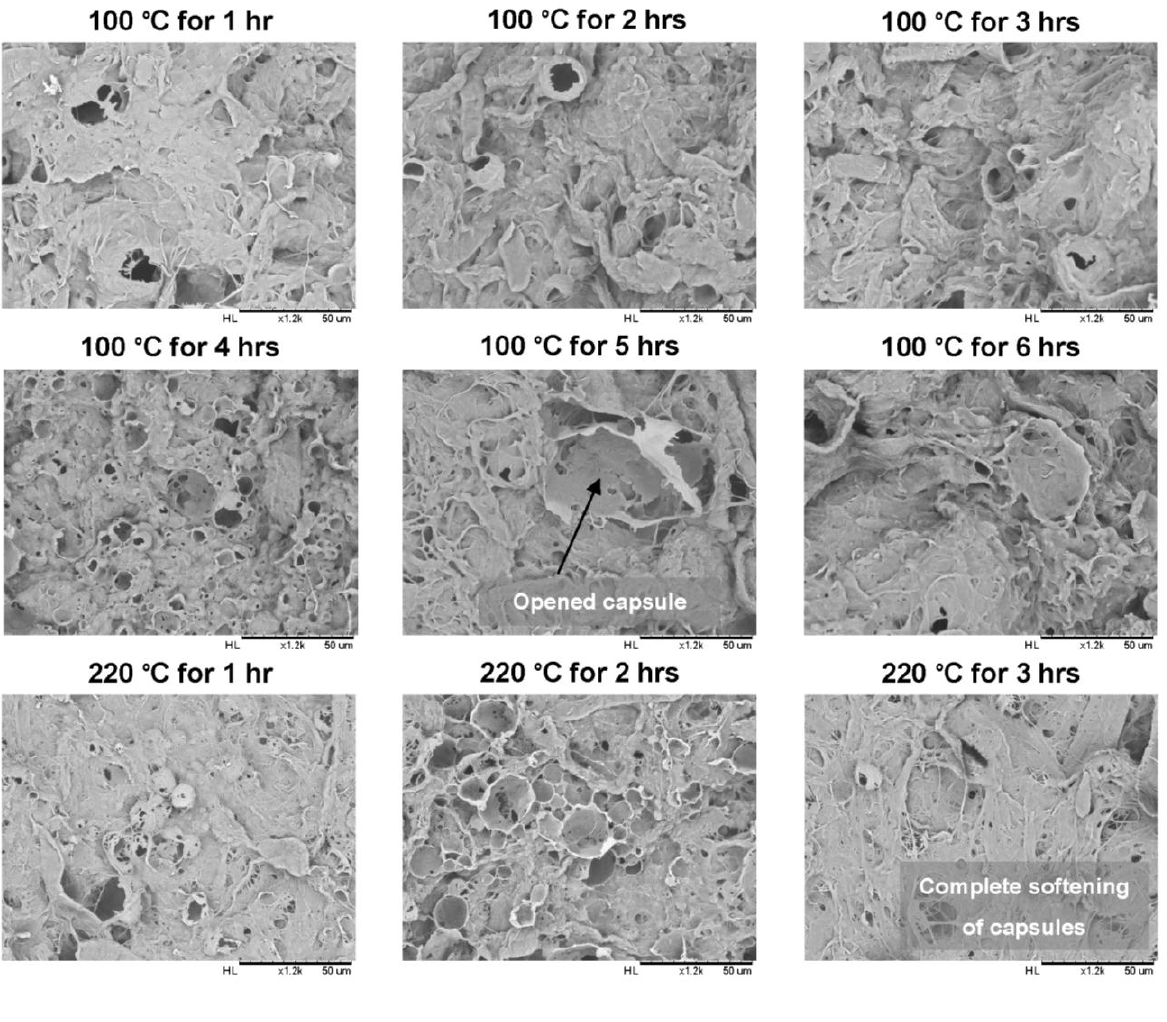
Figure 6. Morphology of cured modified MFC films at 100 and 220 °C for different curing times by scanning electron microscopy